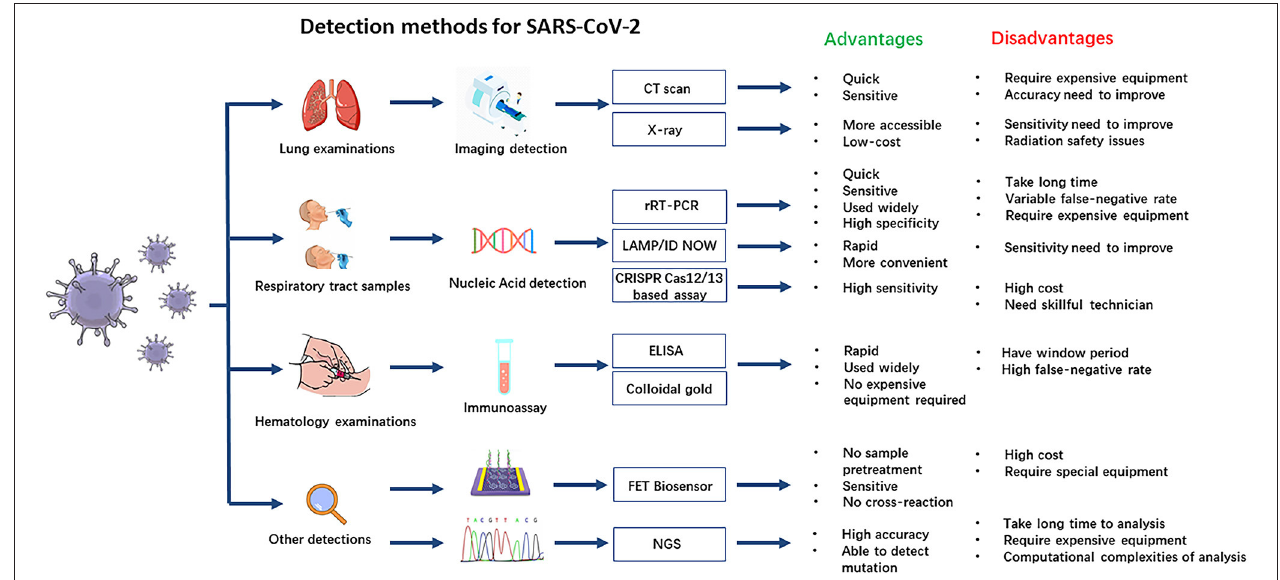
FIGURE 1 | The detection methods for severe acute respiratory syndrome coronavirus 2